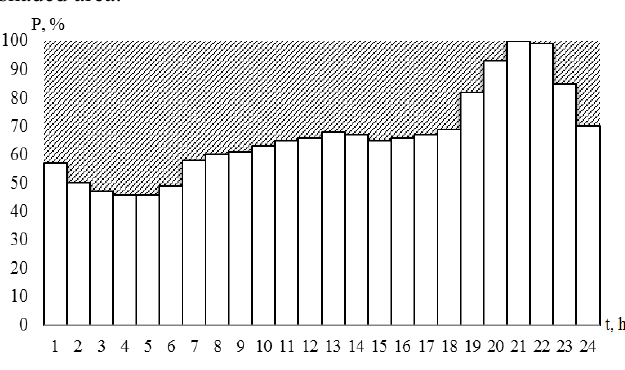
Figure 1. Novosibirsk city consuming municipal load curve (shaded area is underused power energy) To increase the network and equipment loading and solve the load curve optimal completing problem.